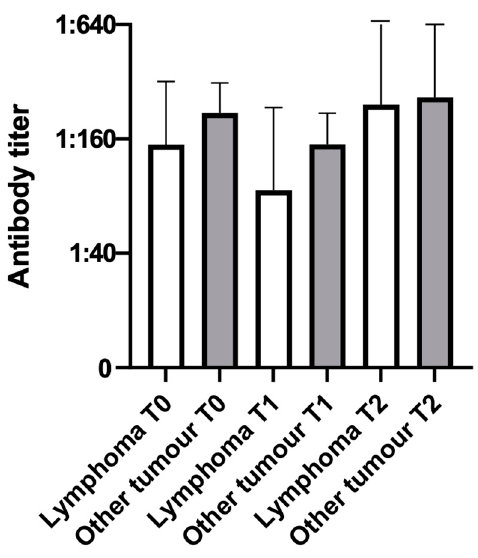
Figure 2. Antibody titers toward parvovirus infection at different timepoints in dogs with lymphoma ( n = 10) and dogs with tumors other than lymphoma ( n = 11).